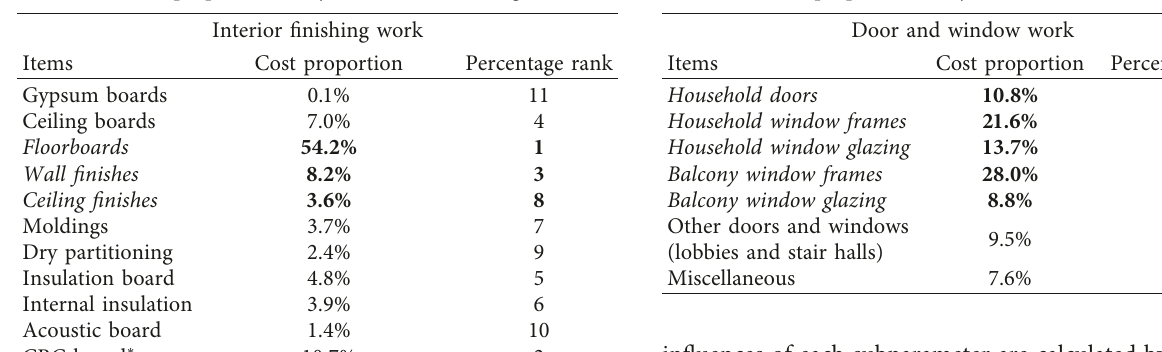
Table 3: Cost proportion analysis (interior finishing works). Table 4: Cost proportion analysis (door and window